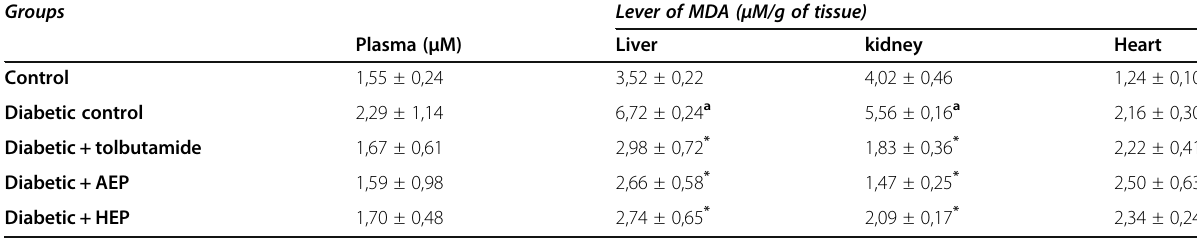
Table 5 Effect of peel extracts of I. Wombolu on the level of MDA in plasma, liver, kidney, and heart Groups